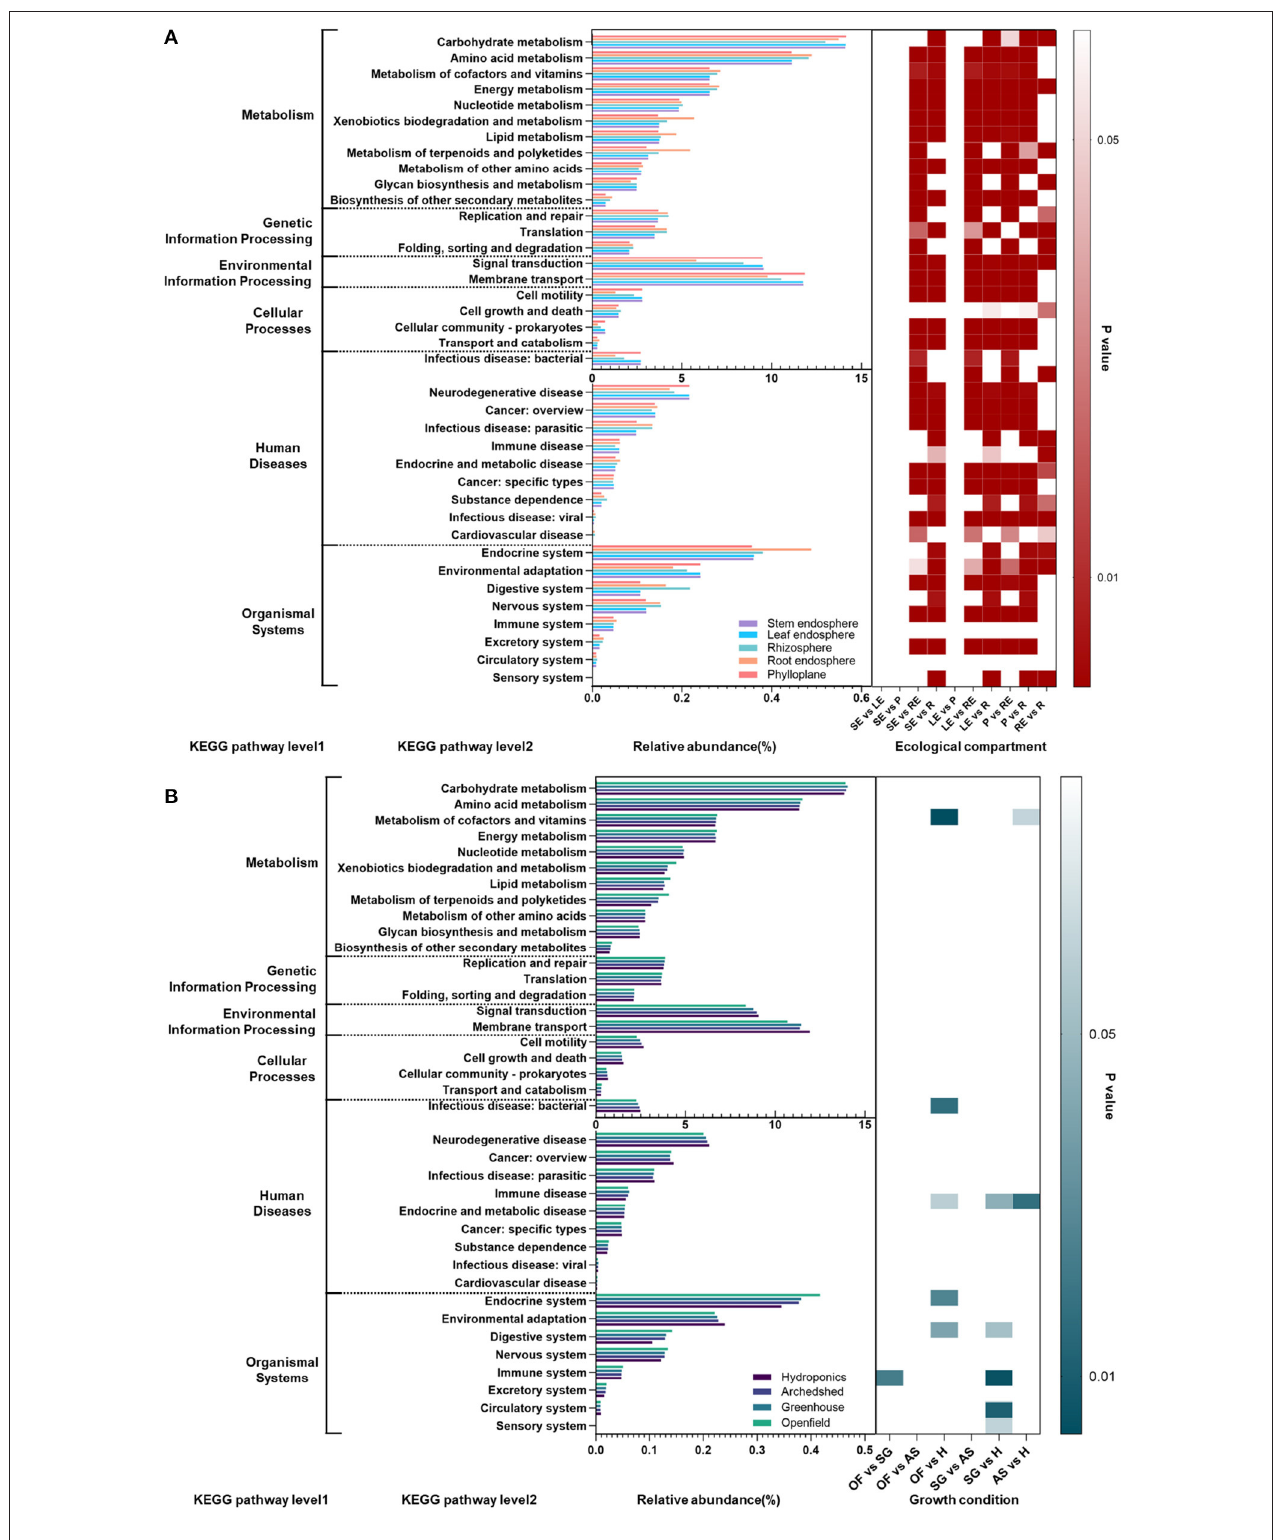
FIGURE 6 | (A) Prediction and analysis of bacterial metabolic pathways in different ecological compartments and different growth conditions. SE, stem endosphere; LE, leaf endosphere; P, phylloplane; RE, root endosphere; R, rhizosphere. (B) The bar chart shows the abundance of each group, and the different levels of metabolism are separated by dark gray lines. The heatmaps on the right side indicate significant pairwise differences in abundance and are plotted based on the P values. OF, open field; SG, solar greenhouse; AS, arched shed; H, hydroponics.